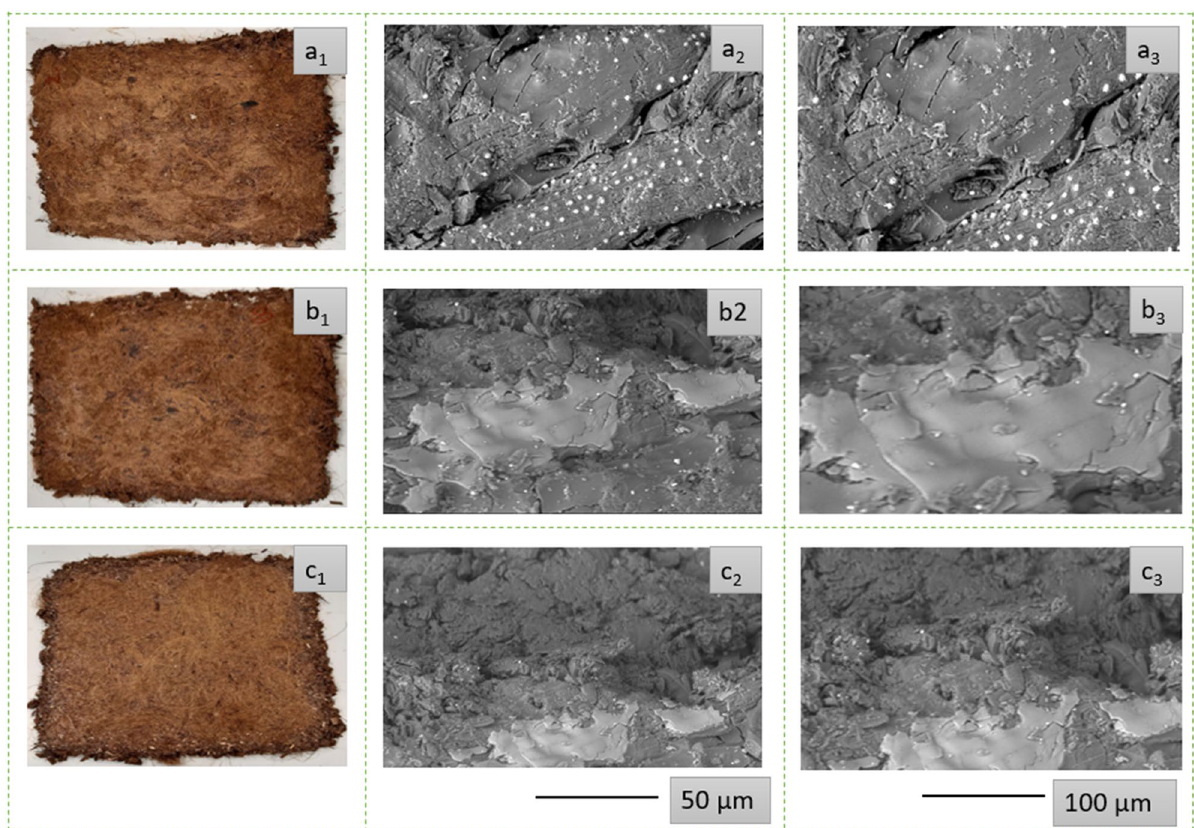
Figure 5. SEM photographs of coir (LCF and CFC) reinforced biocomposites: (a 1 , b 1 , and c 1 ) physical photographs of C@BC 1, C@BC 2, and C@BC 3; (a 2 , b 2 , and c 2 ) SEM images of C@BC 1, C@BC 2, and C@BC 3 at 50 µm; and (a 3 , b 3 , and c 3 ) SEM images of C@BC 1, C@BC 2, and C@BC 3 at 100 µm